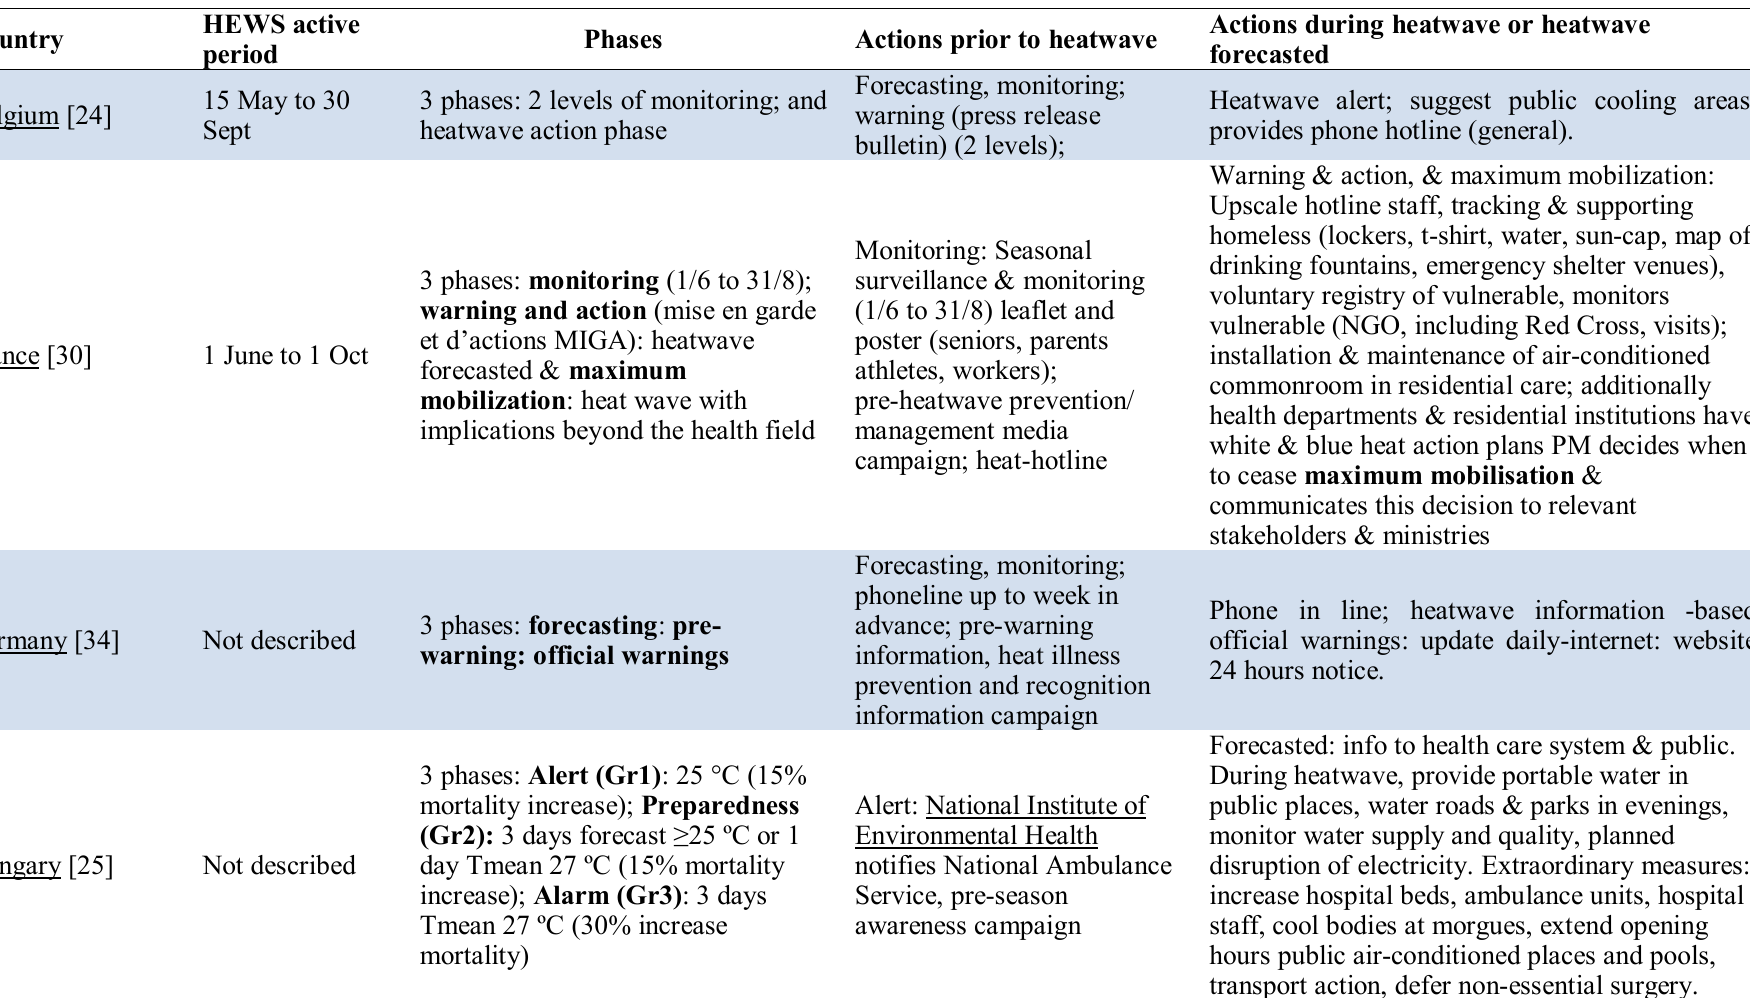
Table 3. Description of the levels or phases in the